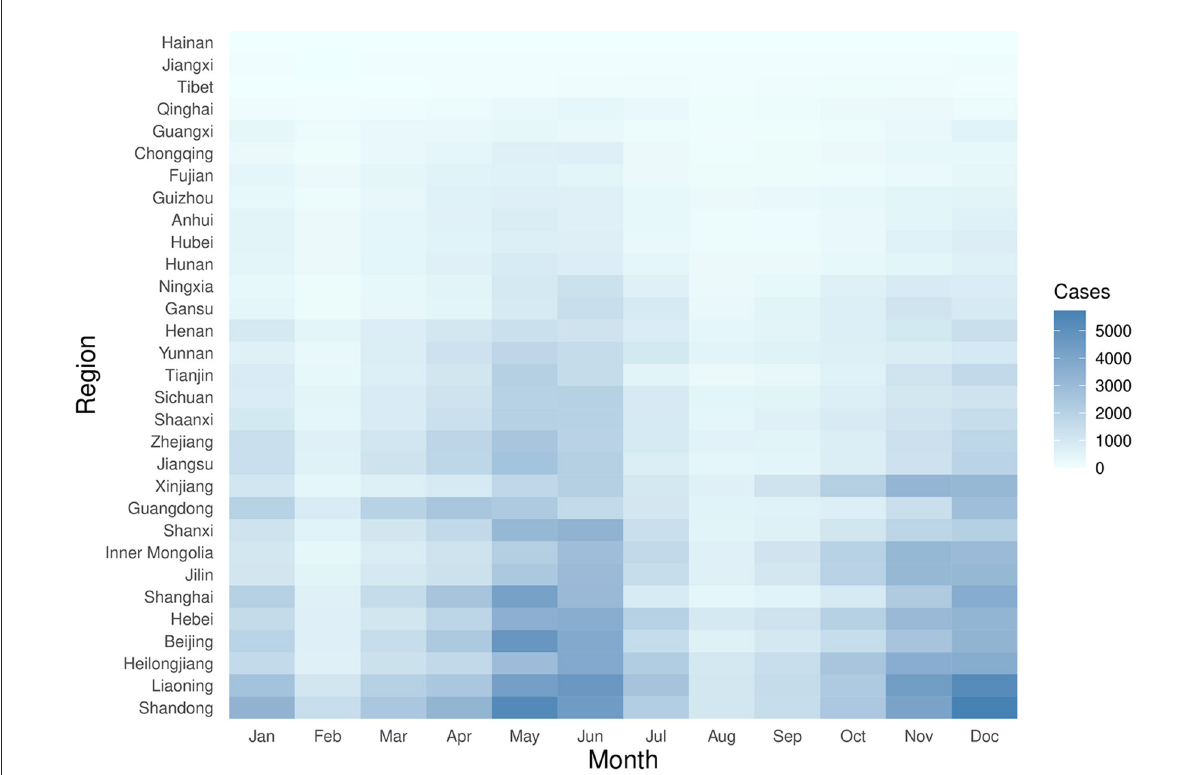
FIGURE2 The time series of monthly number of cases from 2011 to 2017, standardized by the monthly number of cases reported by each province according to the total number of scarlet fever cases recorded in the 7 years.